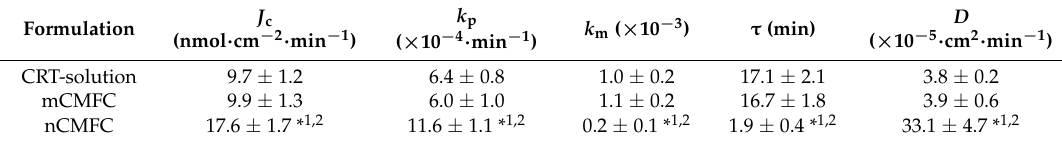
Table 1. Pharmacokinetic analysis of carteolol in the in vitro transcorneal penetration of nCMFC. Formulation